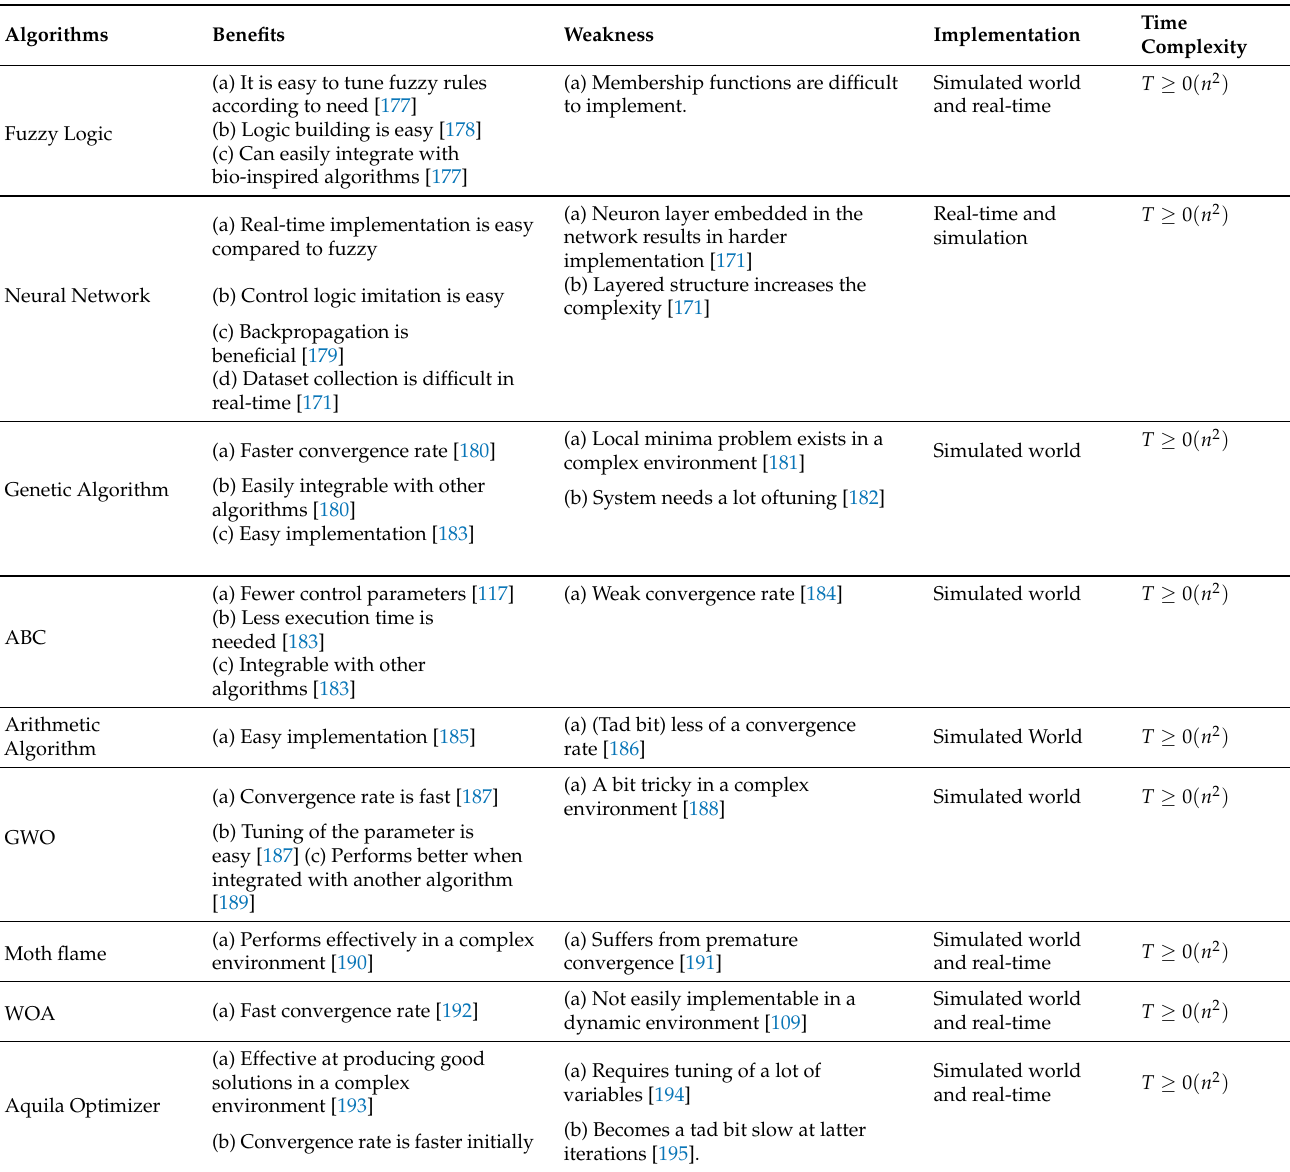
Table 5. Benefits and weaknesses of algorithms involved in autonomous vehicle path